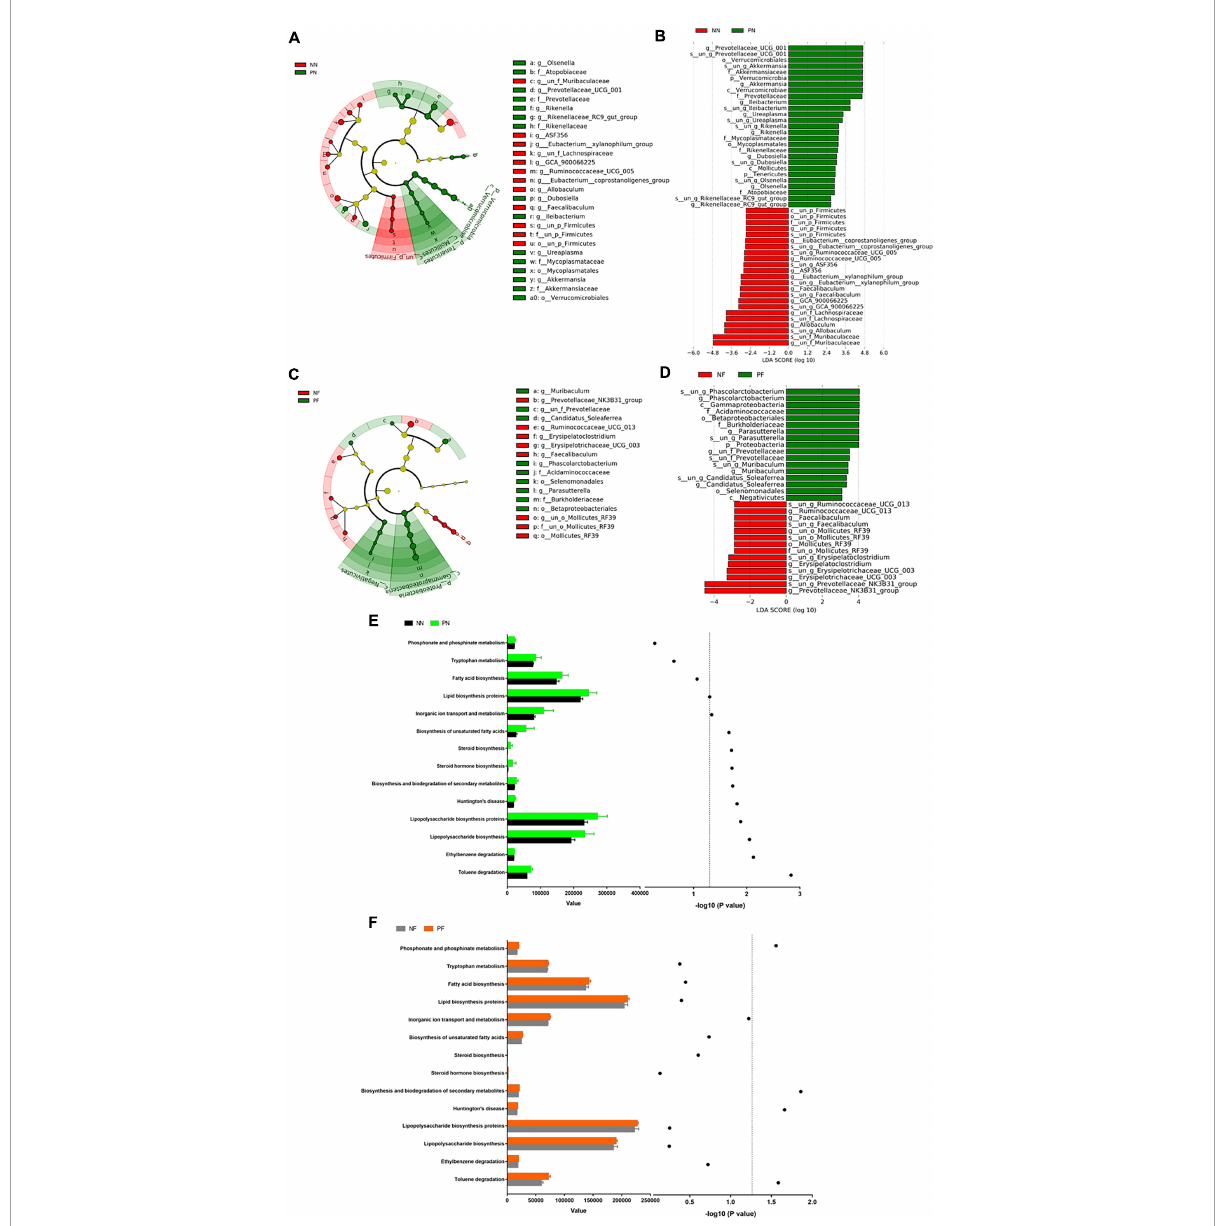
FIGURE5 Alternations in the composition and function of gut microbiota caused by light/dark phase shift and FMT. (A) Cladogram between NN and PN groups. (B) LDA value distribution diagram between NN and PN groups. (C) Cladogram between NF group and PF group. (D) LDA value distribution diagram between NF group and PF group. (E) KEGG metabolic pathway analysis between NN and PN groups. (F) KEGG metabolic pathway analysis between NF and PF groups. The left x-axis represents the abundance of functional genes in the metabolic pathway in each group; the right x -axis means –log 10( P -value). The symbols in panel (E) mean the value of –log 10( P -value) of the different metabolic pathways between NN and PN groups. The symbols in panel (F) mean the value of –log 10( P -value) of the different metabolic pathways between NF and PF groups. The dotted line means the value of –log 10( P -value) is 1.3. The value of –log 10( P -value) > 1.3 was considered statistically significant. NN vs. PN, NF vs. PF. n = 6 per group. NF, mice received FMT from the NN group; PF, mice received FMT from the PN group. NN, Non-phase shift; PN, Phase shift; LDA, Linear Discriminant Analysis; FMT, fecal microbiota transplantation.